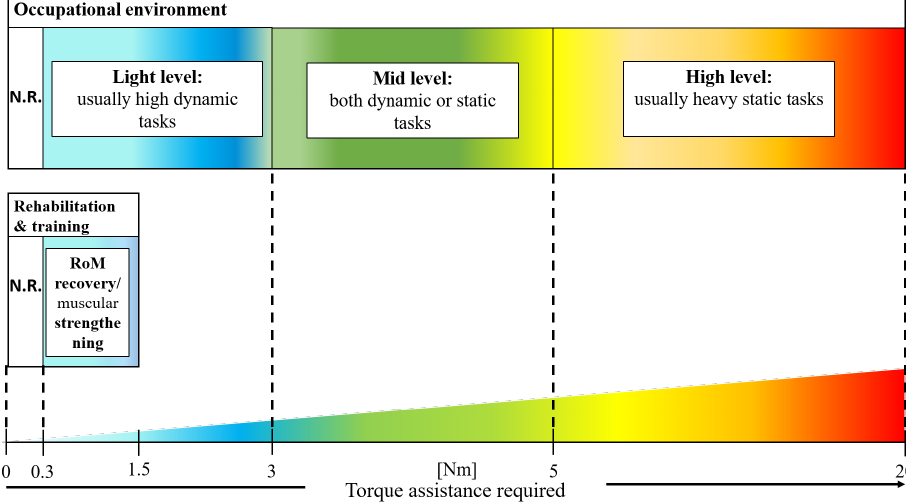
Figure 12. Torque assistance according to applications. Consider applying torque to the center of the rear of the hand, about 0.1 m far from the wrist axis, as done by [54]. Assistance is not required (N.R) if the task requires less than 0.3 Nm of aid, since it is below that required for support a bare hand [39,51,52,56]. In rehabilitation tasks, a torque ranging from 0.3 to 1.5 Nm is common [39,51–53]. These are minimum and maximum acceptable values to guarantee movements recovery and muscular strengthening, and they are dependent on the severity level of the impairment. In the occupational sector , where users are considered healthy, possible ranges are wider due to different loads which have to be handled: a light level of assistance is needed for fast, repetitive activities with small loads; a moderate level of assistance is needed for tasks which require torque between 3 and 5 Nm, a range which, according to safety regulations, is the onset point of WRMSDs; a high level of assistance is needed for tasks which require torque above 5 Nm, usually tasks in which heavy loads are